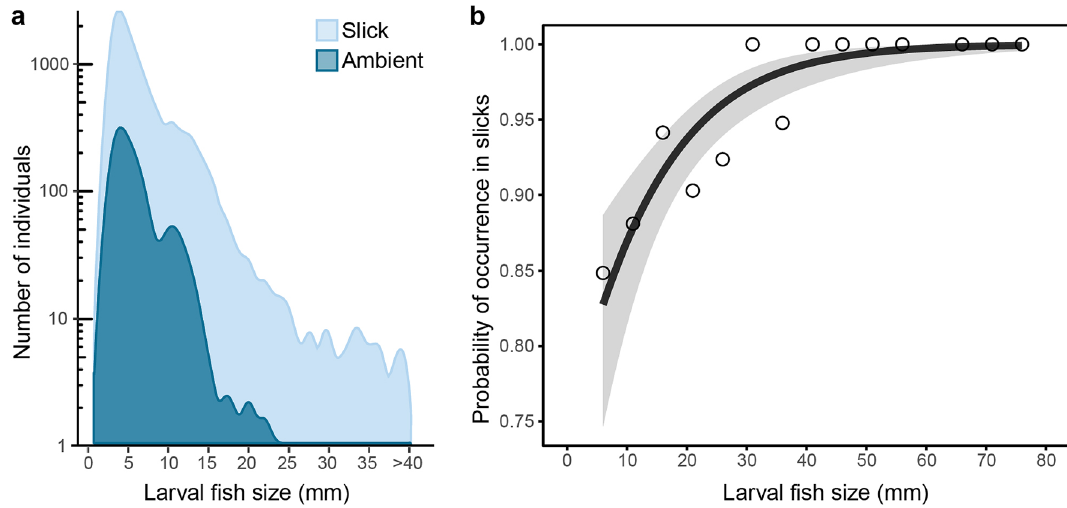
Figure 6. Larval fish size structure in slicks and ambient waters. ( a ) Size frequency histogram of larval total length (mm, in 1-mm size bins) in slicks ( n = 11,772) and ambient waters ( n = 1427). ( b ) Beta regression analysis of the predicted probability of larval fish occurrence in surface slicks versus ambient water as a function of larval fish size (total length, mm, in 5-mm size bins). Observed values are in open circles, black line is the modeled probability ± standard error (grey